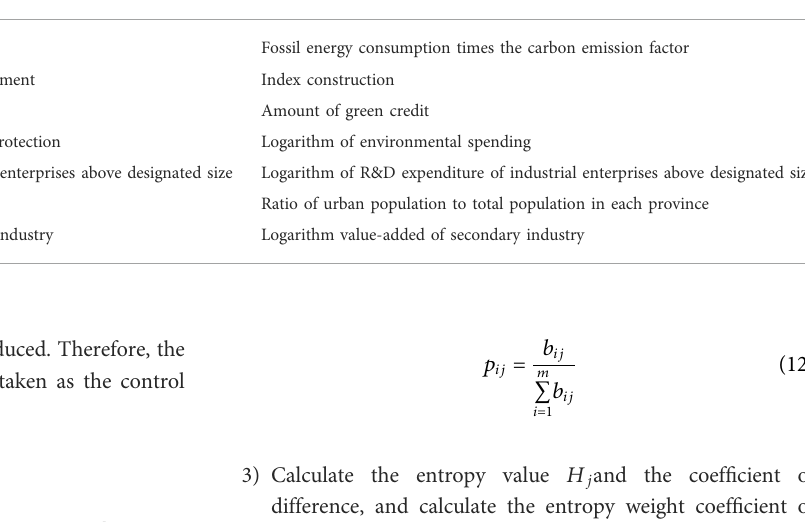
TABLE 2 Variable de fi